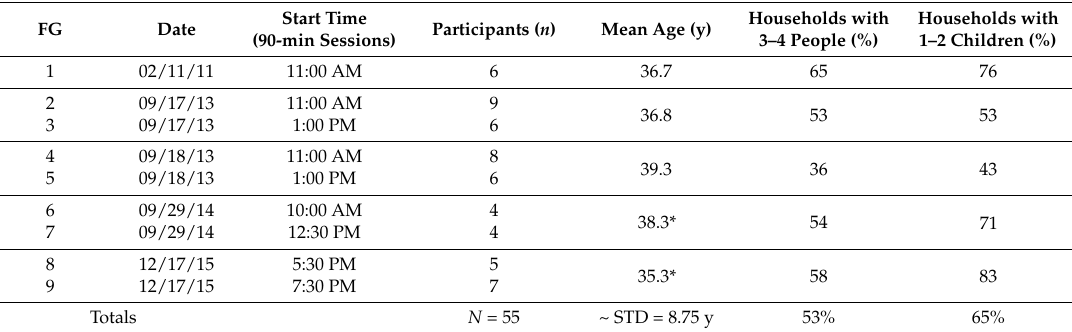
Table 1. Demographics of focus group (FG) participants ( N =